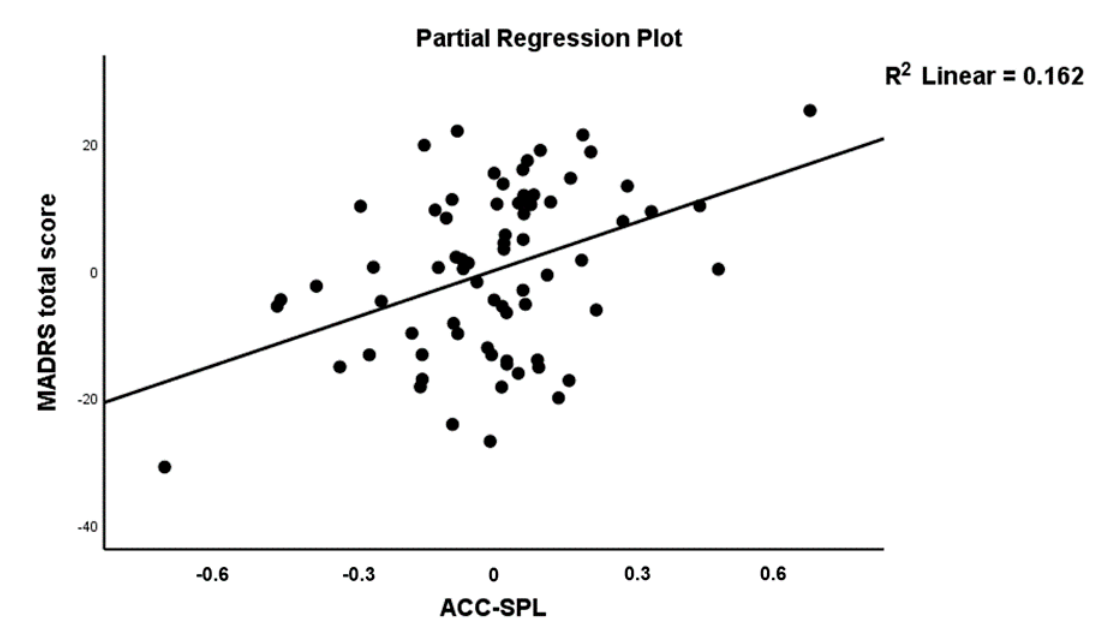
Figure 4. Partial regression plot of the MADRS score on the ACC → SPL connection.